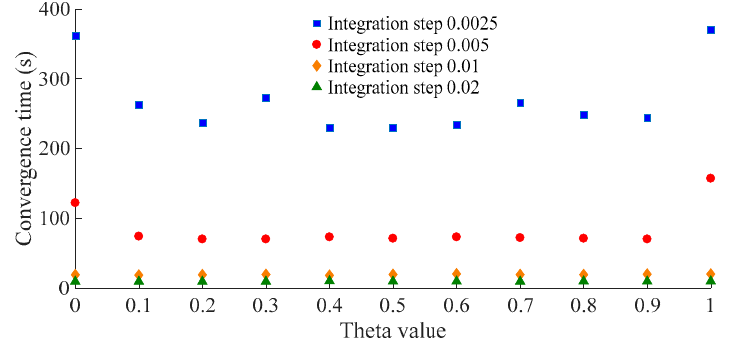
Figure 10. Computation time depending on the value of Theta when a short circuit is applied at bus 16.